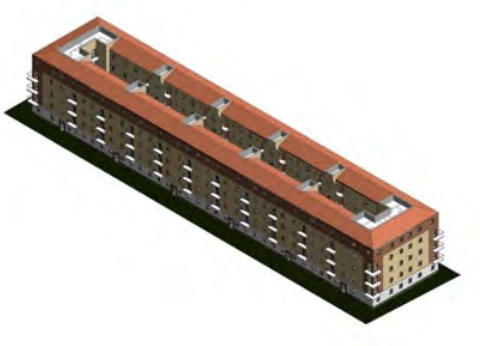
Figure 5. 3D image of the block